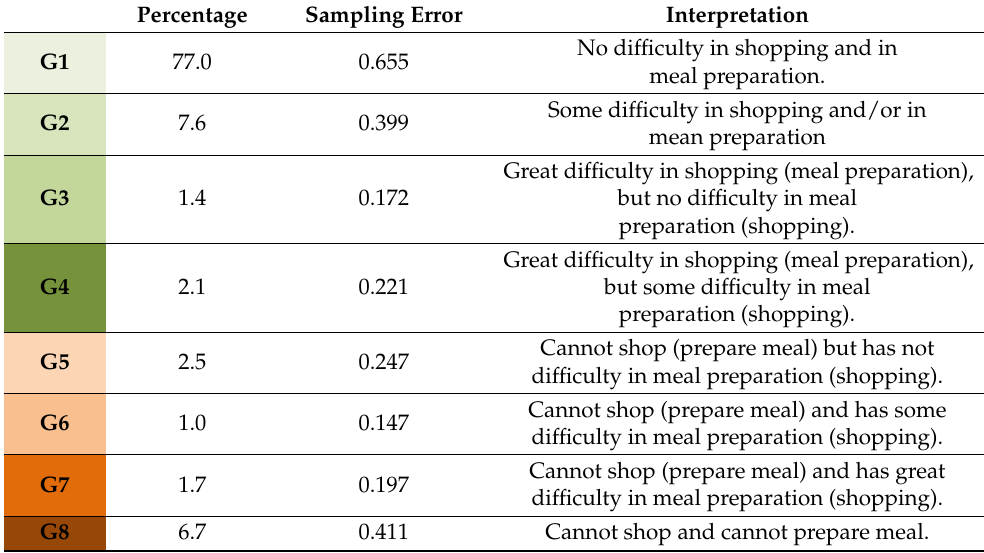
Table 3. Estimated proportion of people in each group (%) and sampling error. Percentage Sampling Error Interpretation No difficulty in shopping and in G1 77.0 0.655 meal preparation. Some difficulty in shopping and/or in mean preparation Great difficulty in shopping (meal preparation), 0.172 but no difficulty in meal preparation (shopping).